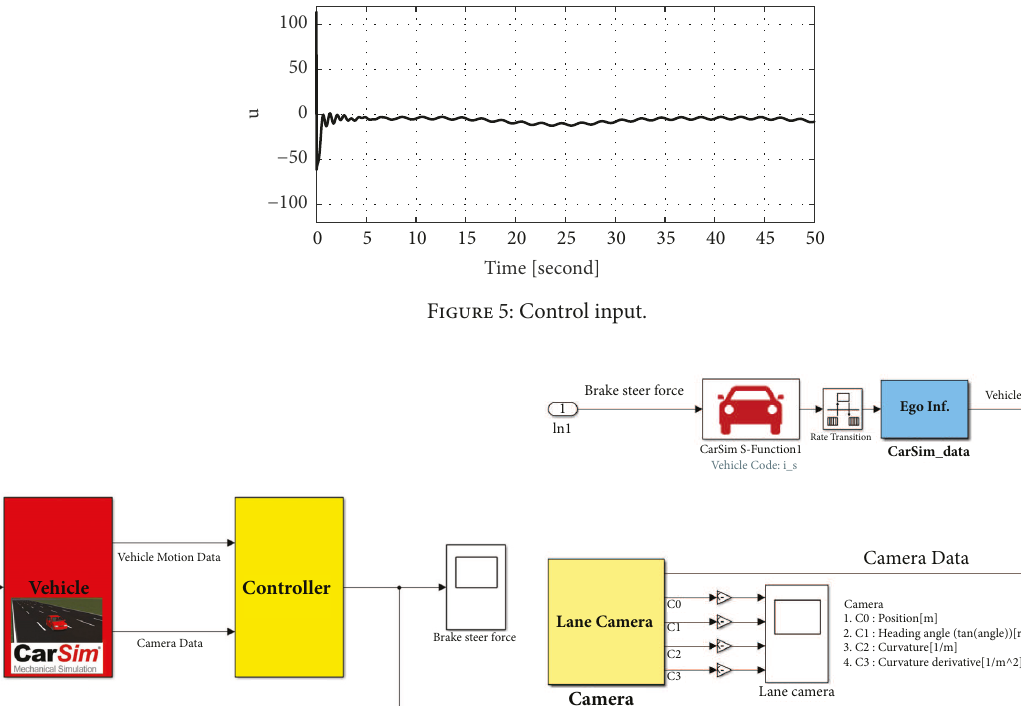
(b) Vehicle part. The output of lane camera is lane coefficients; 𝑐 0 denotes the lateral lane center offset at c.g., 𝑐 1 denotes the in-lane heading slop, the heading angle error at c.g., 𝑐 2 denotes curvature/2 at 𝑠 = 0 , and 𝑐 3 denotes the curvature-rate/6 Figure 6: Vehicle and camera models used in the simulations.